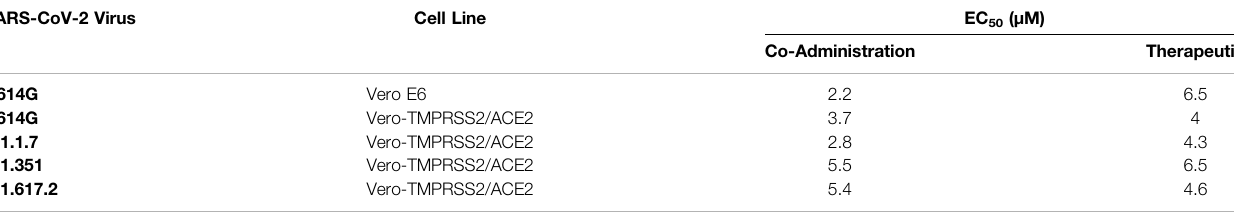
TABLE 1 | 50% effective concentration (EC 50 ) of azelastine against various SARS-CoV-2 spike protein mutants and variants in the preventive and therapeutic settings. SARS-CoV-2